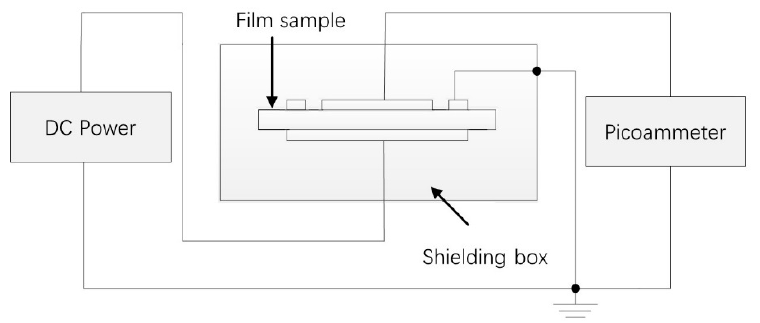
Figure 2. The schematic diagram of the conductivity test system.